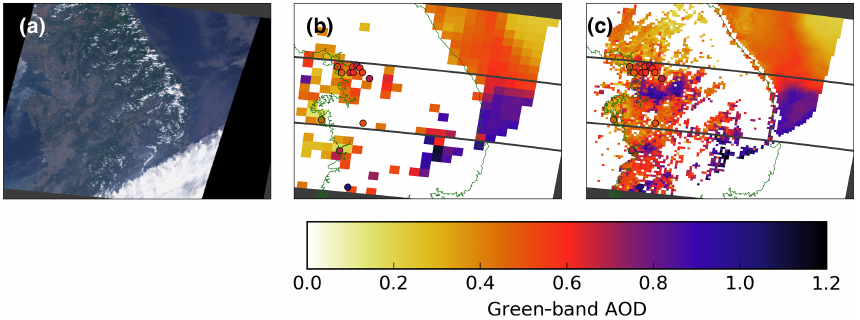
Figure 7. (a) The MISR true-color (RGB) image of the Korean peninsula on 25 May 2012 at around 02:20UTC; (b) MISR V22 17.6km aerosol optical depth (AOD); (c) MISR 4.4km AOD retrieved using the prototype